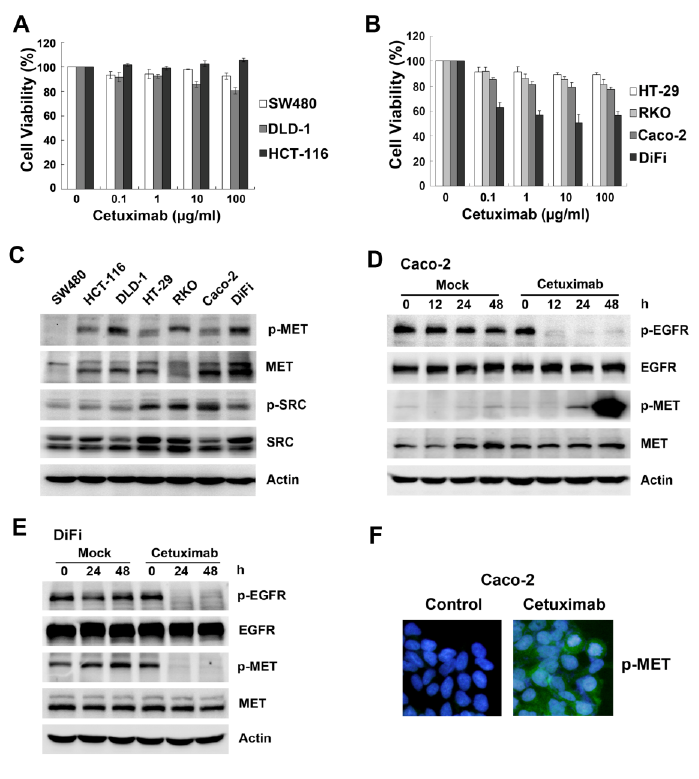
Figure 1. Cetuximab induces MET phosphorylation in cetuximab-insensitive Caco-2 cells but not in cetuximab-sensitive DiFi cells. ( A , B ) Three KRAS mutant colon cells (SW480, DLD-1 and HCT-116) and four KRAS wide-type colon cells (HT-29, RKO, Caco-2 and DiFi) were treated with increasing concentrations of cetuximab (0.1, 1, 10, 100 µg/mL) for 72 h after overnight 2% FBS starvation. Cell viability was determined by MTT assay; ( C ) Expression of MET, SRC and phosphorylation levels were examined by Western blotting in seven representative colon cells. Actin was shown as loading control for all Western blotting; ( D , E ) Caco-2 cells and DiFi cells were treated with 10 µg/mL cetuximab for the indicated times. Expression of MET, EGFR and phosphorylation levels were analysed by Western blotting. Caco-2 cells were treated with 10 µg/mL cetuximab for 48 h in 2% FBS medium; ( F ) Cyto-staining for MET phosphorylation on Tyr1234/1235 (green) and nuclei (blue) were detected by